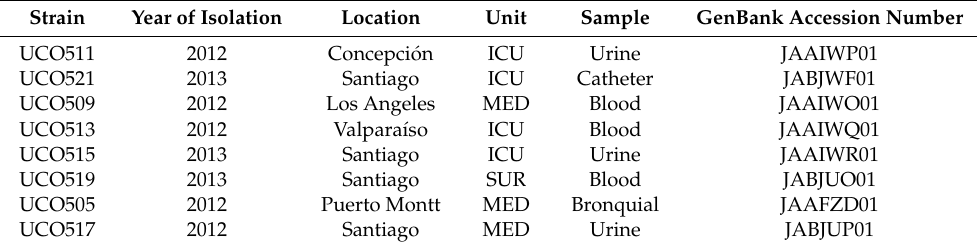
Table 1. Data of the Colistin-heteroresistant (CST-HR) extended-spectrum β -lactamase (ESBL)-producing K. pneumoniae isolates collected in Chilean hospitals.